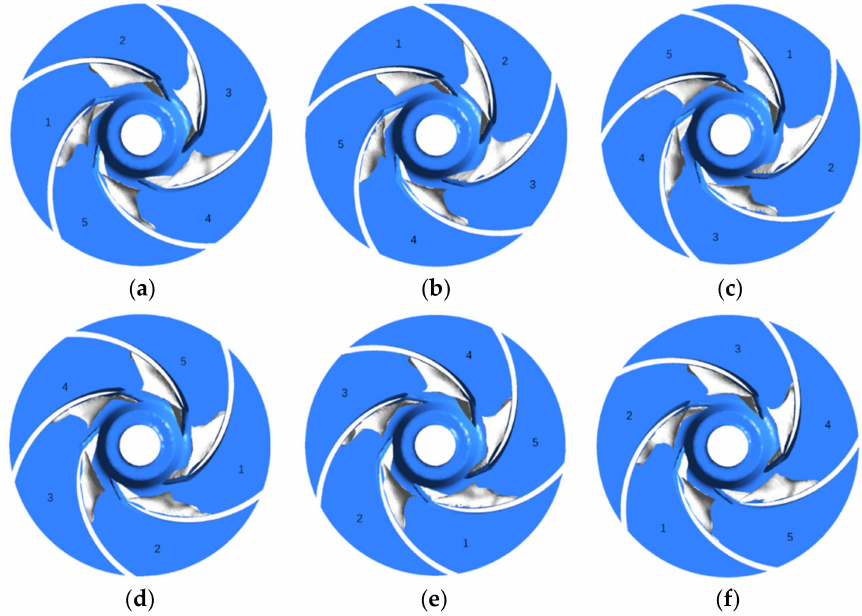
Figure 13. Bubble distribution in the impeller domain. ( a ) t = 0; ( b ) t = 1/6 T; ( c ) t = 2/6 T; ( d ) t = 3/6 T; ( e ) t = 4/6 T; ( f ) t = 5/6